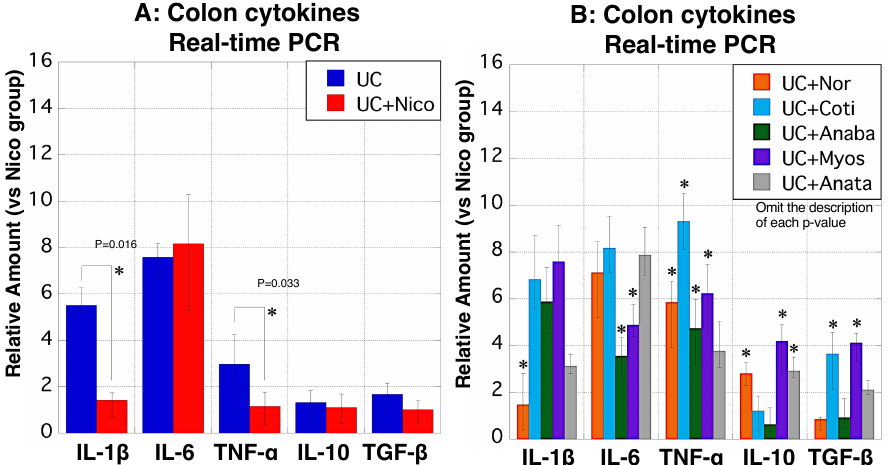
Figure 9. Alterations in colonic mRNA levels of cytokines in rats. ( A , B ) Real-time PCR was performed to detect the mRNA expression in rat colon tissues. The y -axis indicates the mRNA expression levels of IL-1 β , IL-6, TNF- α , IL-10, and TGF- β in the colon tissues of the UC (blue), UC + Nico (red), UC + Nor (yellow), UC + Coti (light blue), UC + Anaba (green), UC + Myos (purple), and UC + Anata (gray) groups, relative to the Nico group. Data values are presented as the median ± max/min. * p < 0.05 (vs. the UC group). Anaba, anabasine; Anata, anatabine; Coti, cotinine; IL-1 β , interleukin-1 β ; IL- 6, interleukin-6; IL-10, interleukin-10; Myos, myosmine; Nico, nicotine; Nor, nornicotine; TGF- β , transforming growth fctor- β TNF- α , tumor necrosis factor- α ; and UC, ulcerative